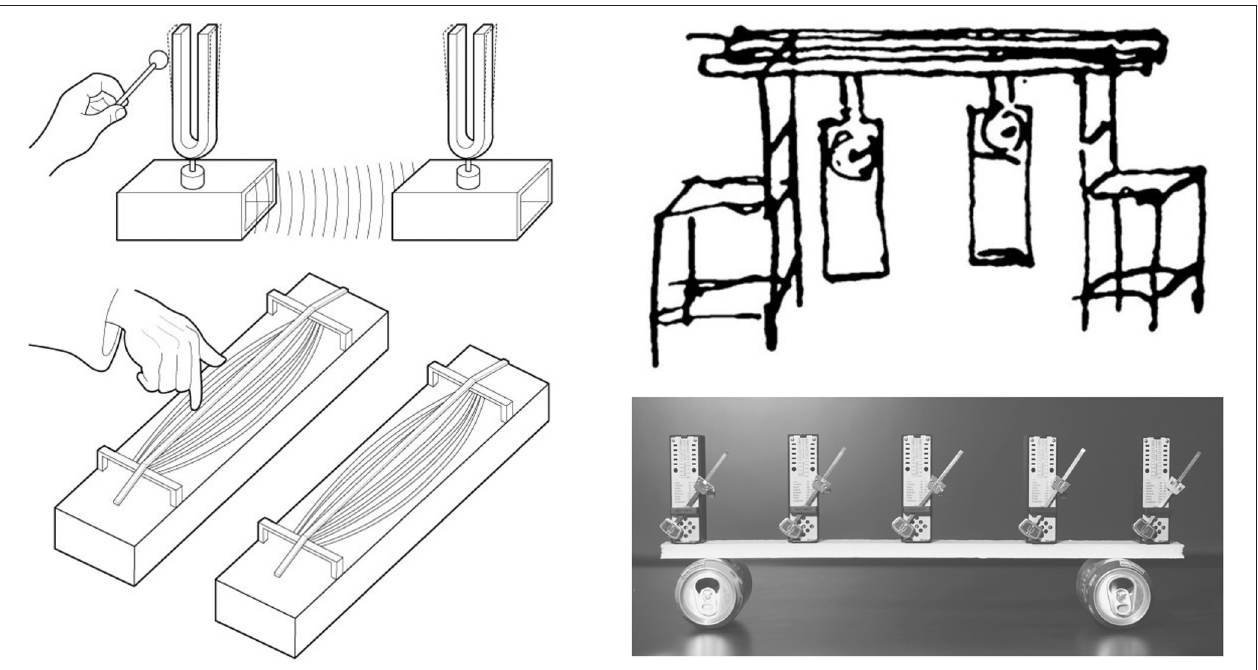
FIGURE 1 | (Left) Resonance between mutually attuned tuning forks and strings involves synchronization and amplification. (Right) Sketch by Christiaan Huygens (b. 1629), who discovered “the sympathy of two clocks.” When two clocks are placed on a common beam, their two pendulums will eventually synchronize. Right bottom: a set of weakly coupled powered metronomes (self-sustained oscillators) will eventually synchronize. Photo courtesy: Harvard Natural Sciences Lecture